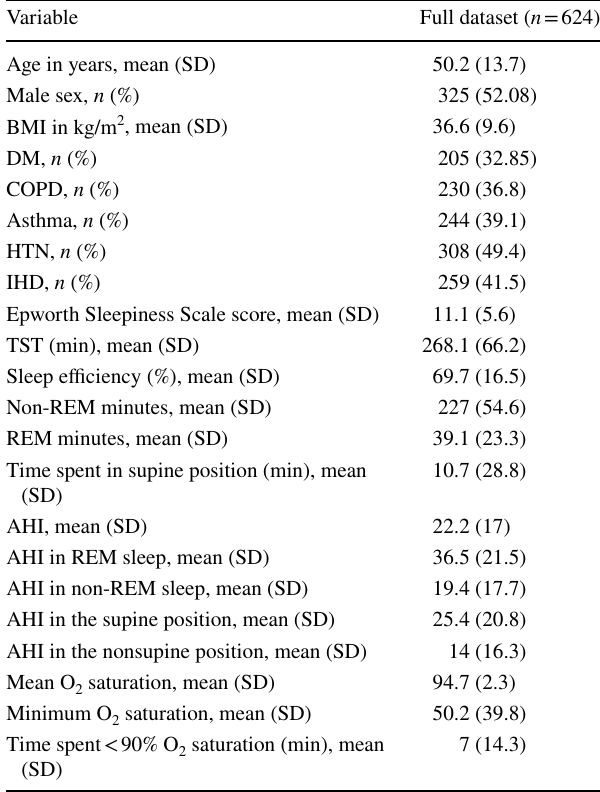
Table 1 General and sleep-related characteristics of the study popula-